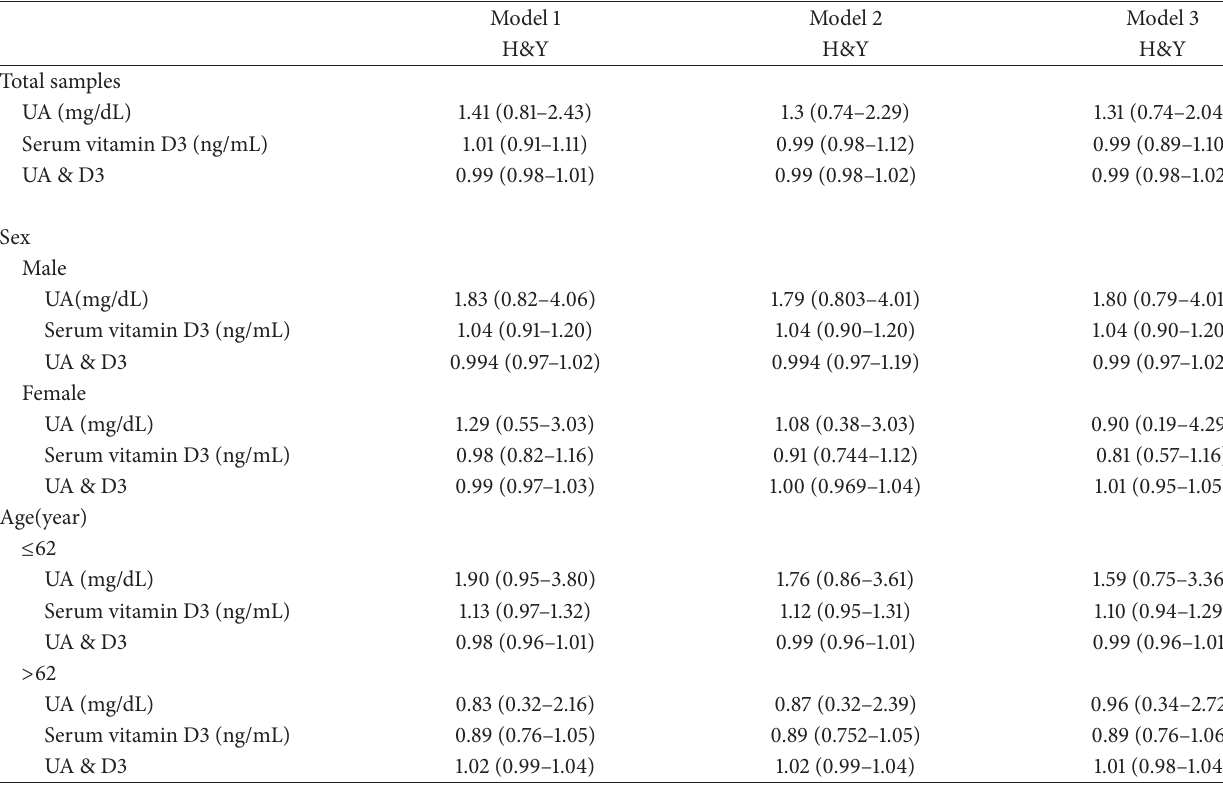
Table 5: Crude and adjusted odds ratio (OR) and 95% CI for OR of the association of H&Y with UA, serum vitamin D3, and their interaction in total study sample as well as in age and sex groups 1